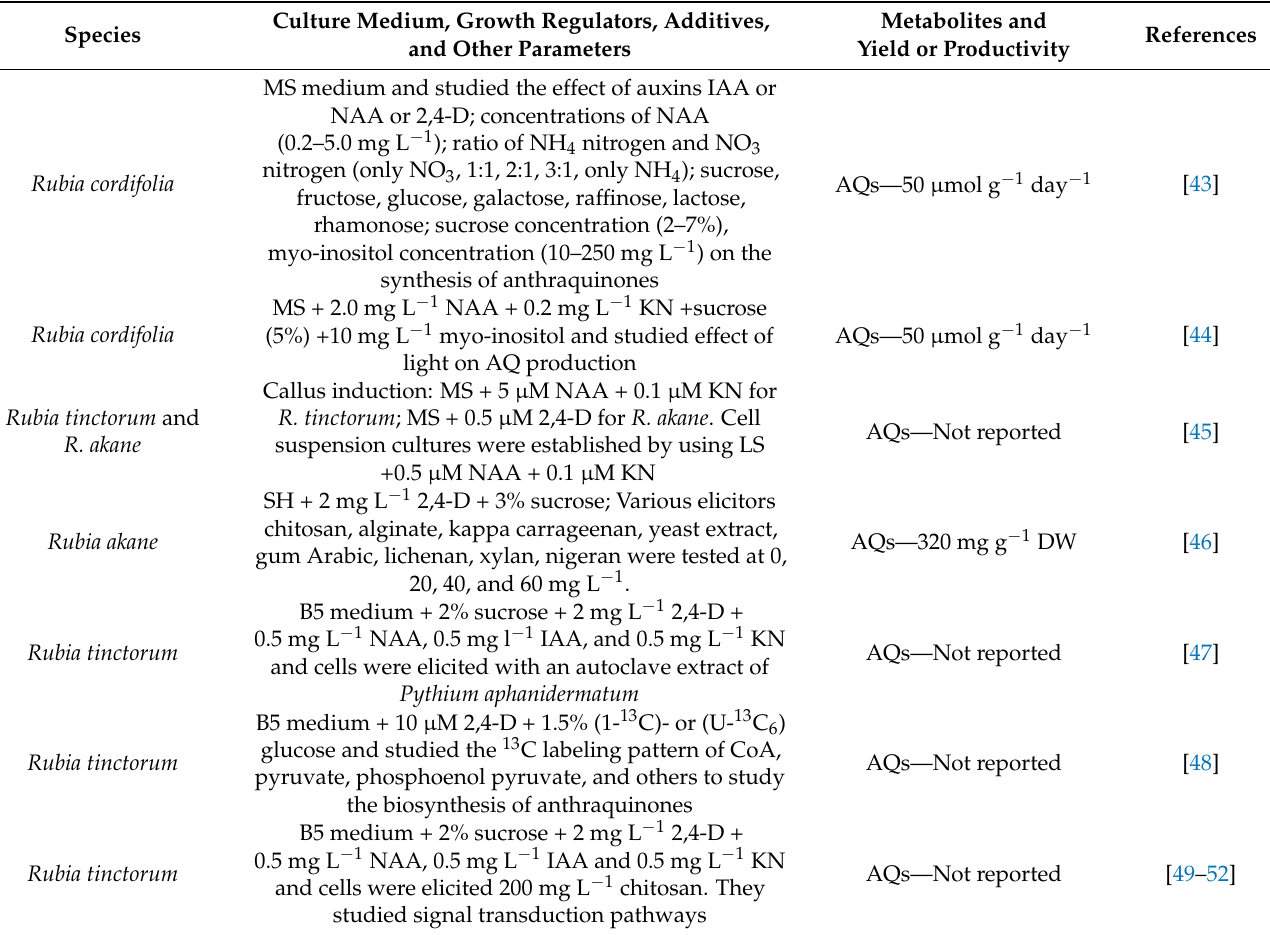
Table 3. Cell suspension cultures for the production of AQs in Rubia